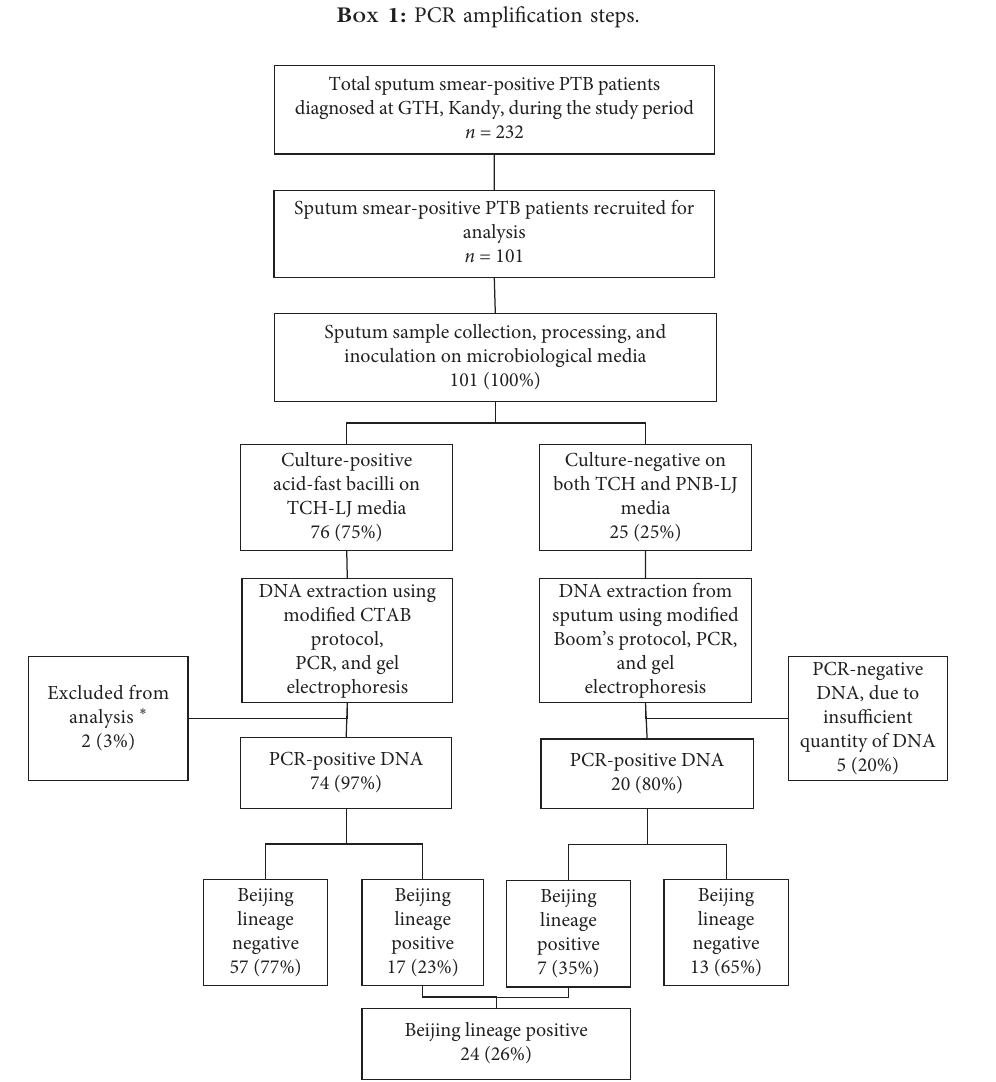
Figure 2: Prevalence of Beijing lineage strains among sputum smear-positive pulmonary tuberculosis (PTB) patients diagnosed in a